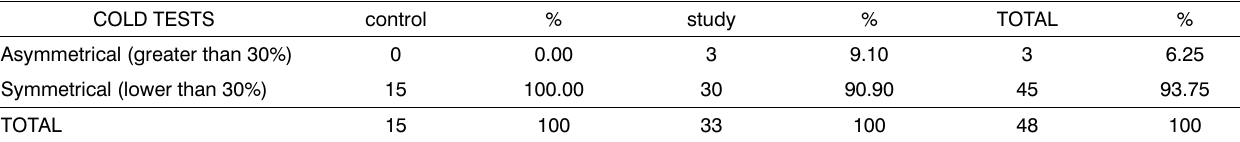
Table 2. Results from the cold tests in all individuals tested.